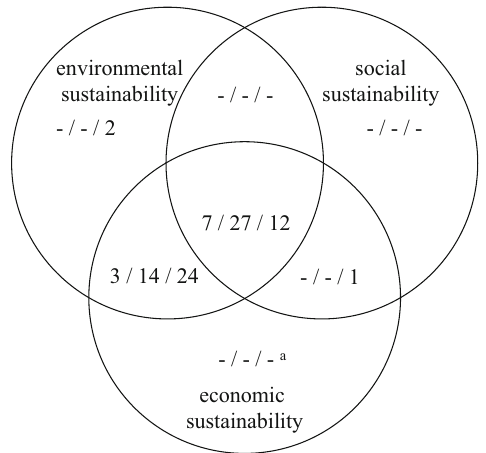
Fig. 3 Dimension of the TBL of